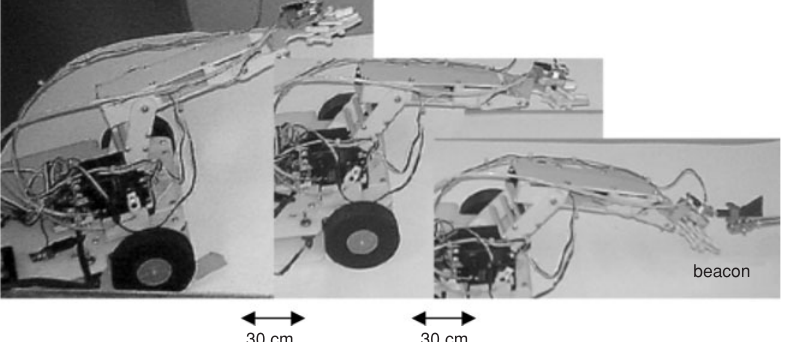
Figure 5 Three photos of the experimental sequencing: { WAIST, SHOULDER, ELBOW,WRIST, WHEELS F/B } . On the left extreme is the attitude and position of the robot at the start. The photo in the middle is the position and grasping attitude of the robot long before reaching the beacon. To the right is the position and attitude of the robot at the beacon. The sensor is nearly touching the beacon. The space rolled by the robot between photos is 30 cm.